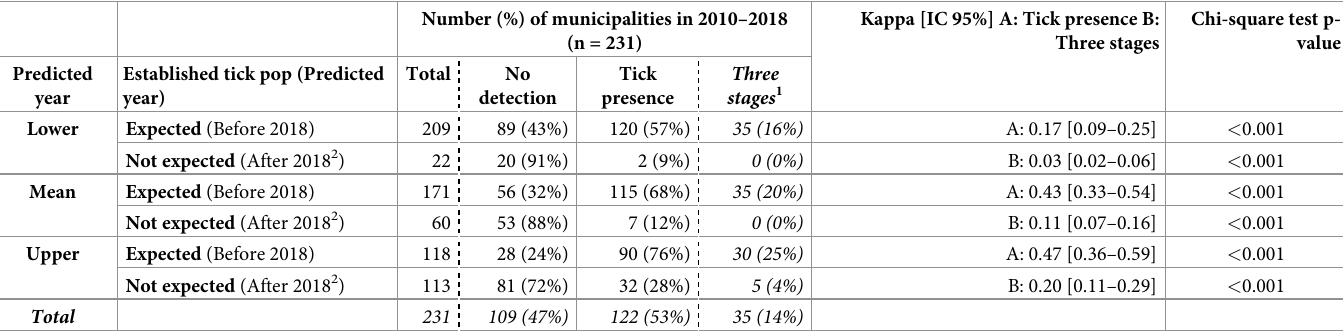
Table 3. Concordance between field data and predicted tick establishment by 2018. Observed presence or absence of ticks during active surveillance (no detection, tick presence, three stages) in municipalities between 2010–2018 vs predicted tick establishment in 2018 (before or after 2018) according to lower, mean and upper model pre- dicted year.